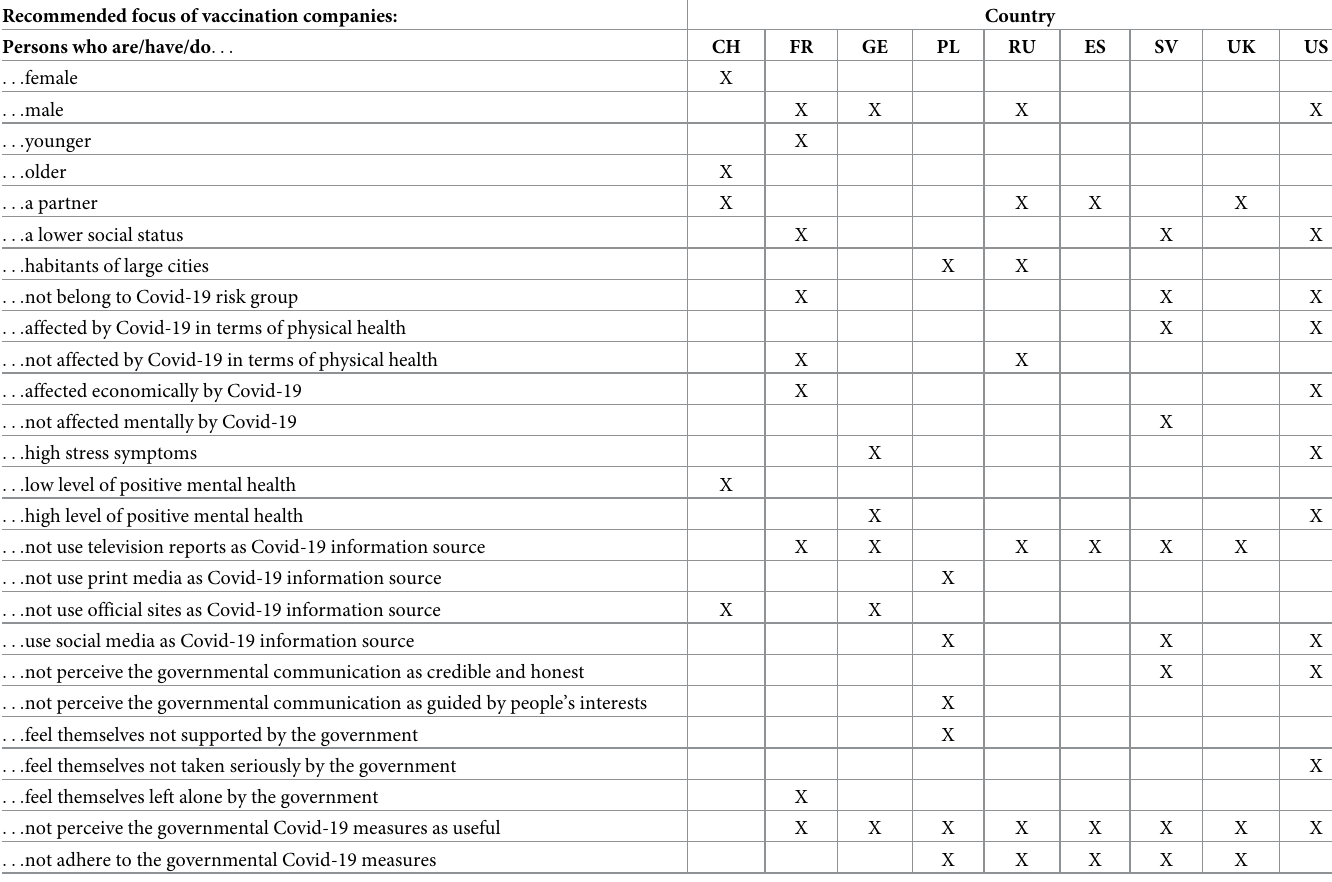
Table 5. Recommended focus of vaccination companies for increase of vaccination willingness based on significant effects of the logistic regression analyses. Recommended focus of vaccination